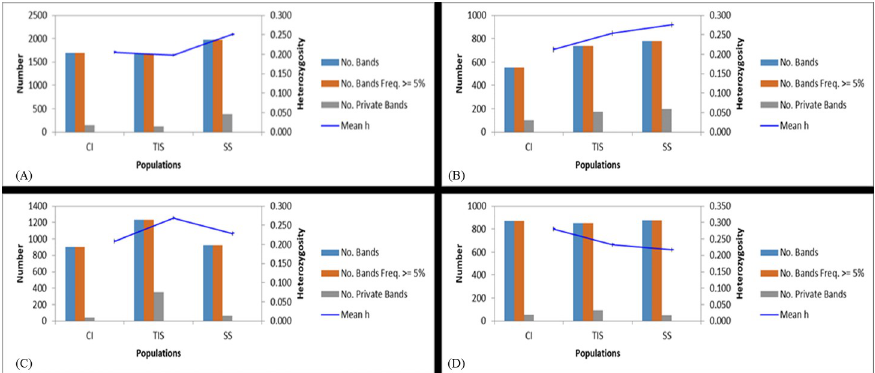
Fig 4. Band Patterns for Musa and Yam. (A) Band patterns across populations for Musa under field conditions ( Mse I). CI, Complete Immersion; TIS, Temporary Immersion System; SS, Semi-Solid, (B) Band patterns across populations for Musa under in vitro conditions ( Mse I). CI, Complete Immersion; TIS, Temporary Immersion System; SS, Semi-Solid, (C) Band patterns across populations for Yam under field conditions ( Mse I). CI, Complete Immersion; TIS, Temporary Immersion System; SS, Semi-Solid, (D) Band patterns across populations for Yam under in vitro conditions ( Mse I). CI, Complete Immersion; TIS, Temporary Immersion System; SS,